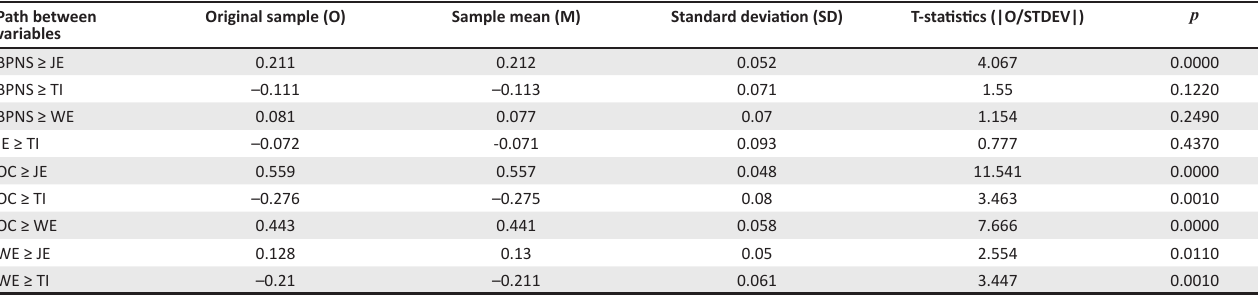
BPNS, basic psychological need satisfaction; OC, organisational commitment; JE, job embeddedness; WE, work engagement; TI, turnover intention. TABLE 7: Inner model (Round 1).